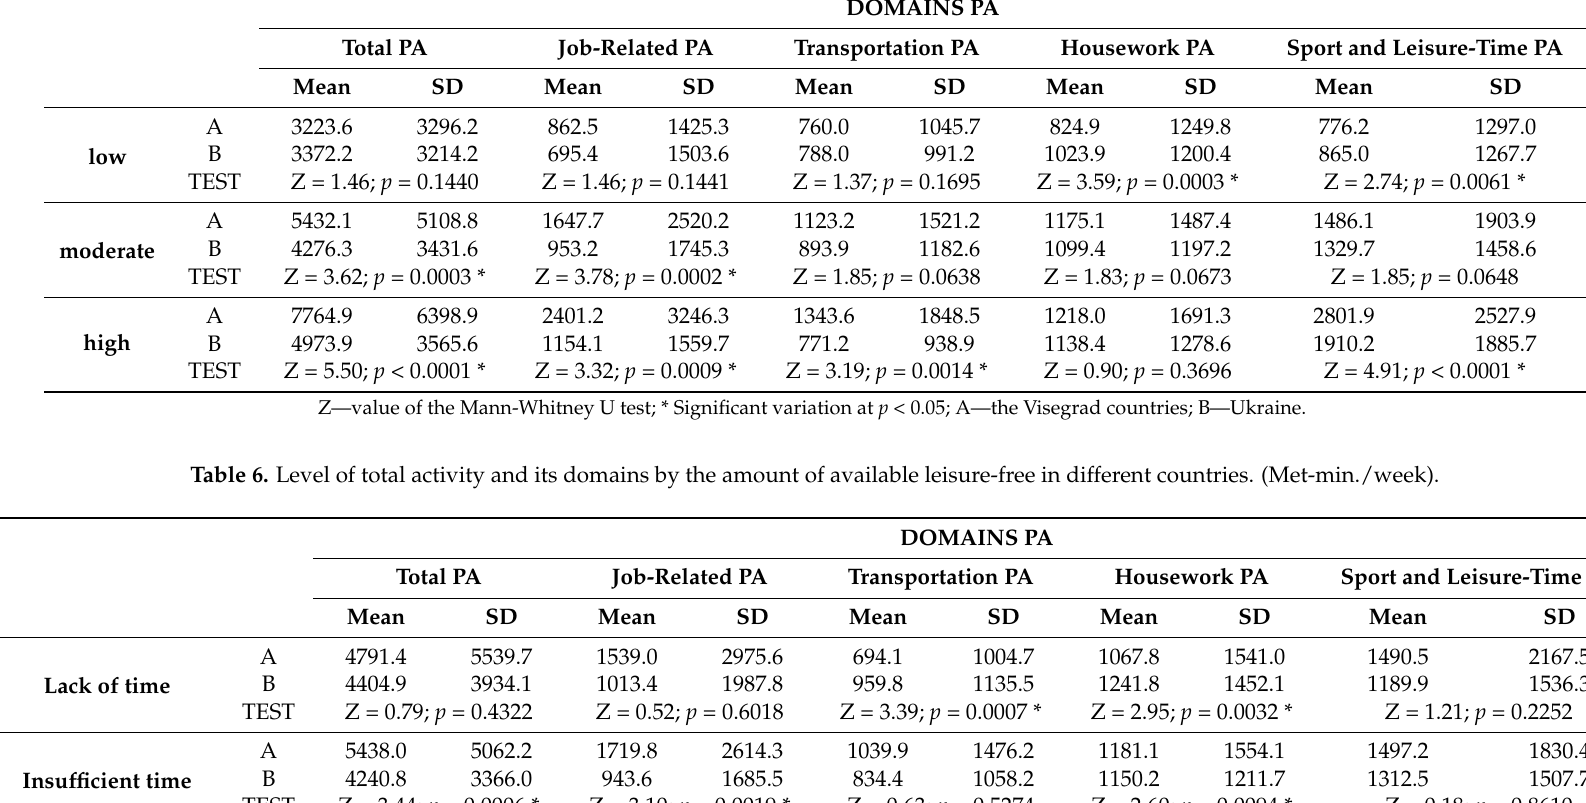
Table 5. Level of total activity and its domains by self-assessment of physical fitness in different countries (Met-min./week). DOMAINS PA